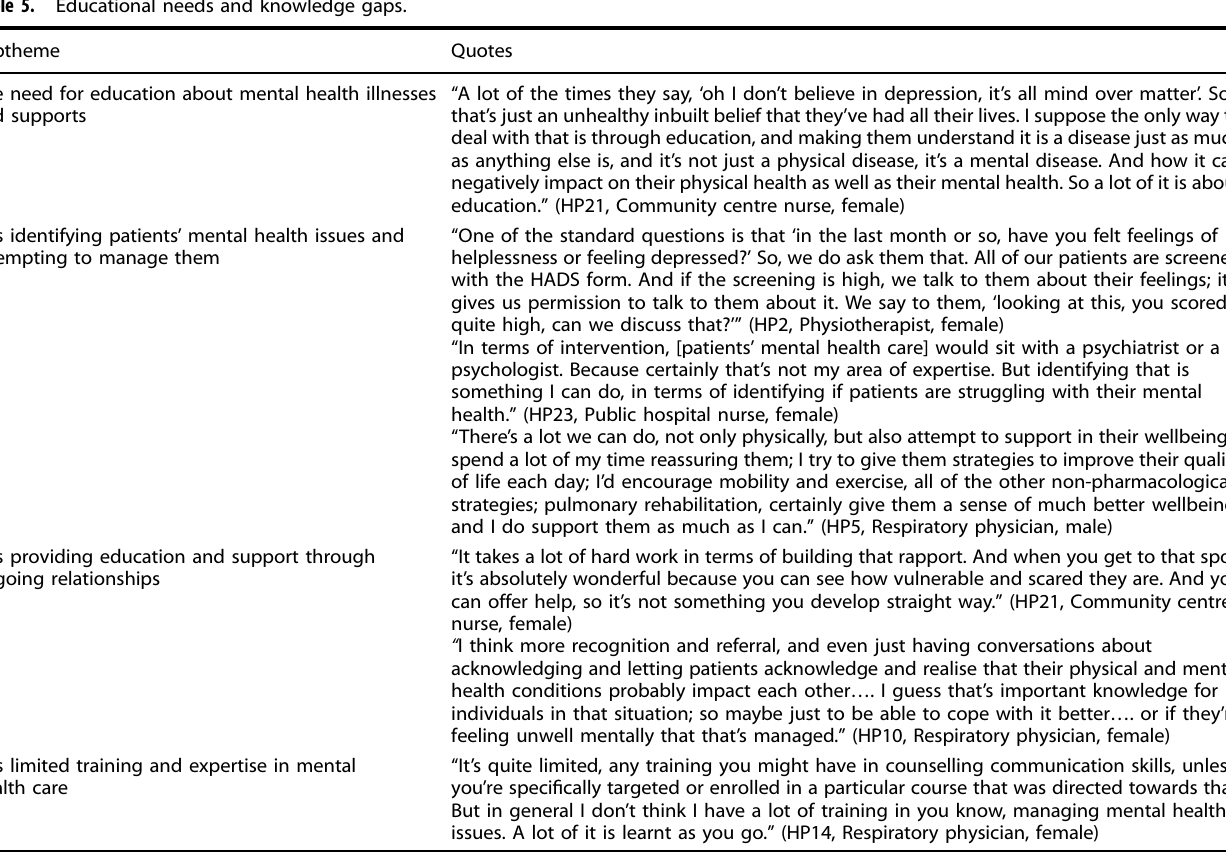
Table 5. Educational needs and knowledge